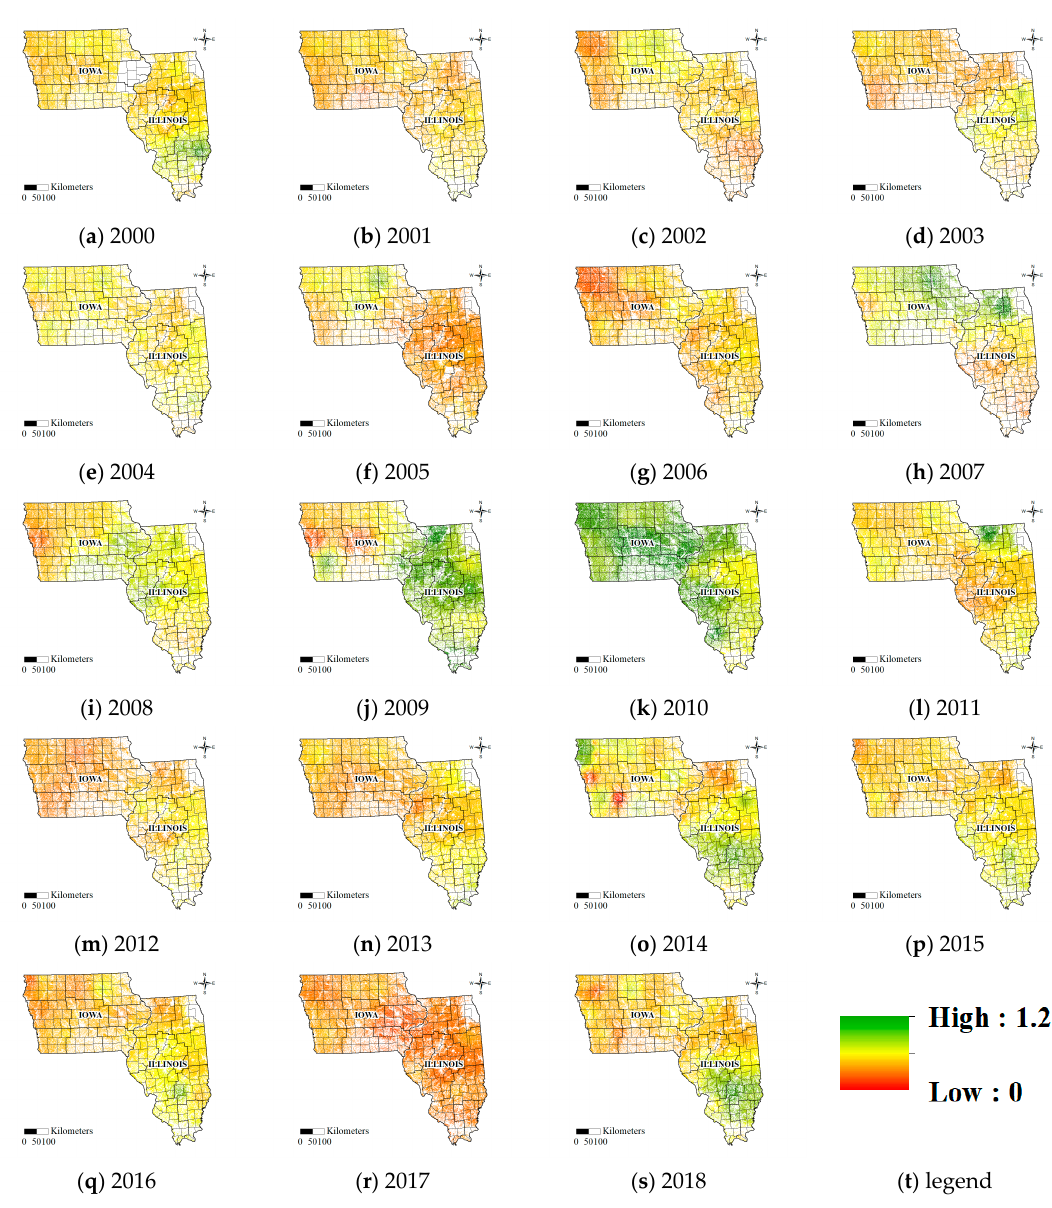
Figure 7. Spatiotemporal distribution of agricultural drought using annual REIC.